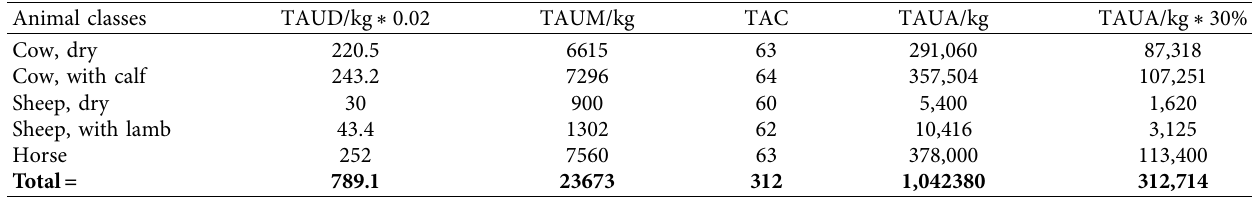
Table 7: Te calculated total animal unit (TAU)/day, #/month, #/annual and correct proper use factor (30%) considered grazing of the Surra government